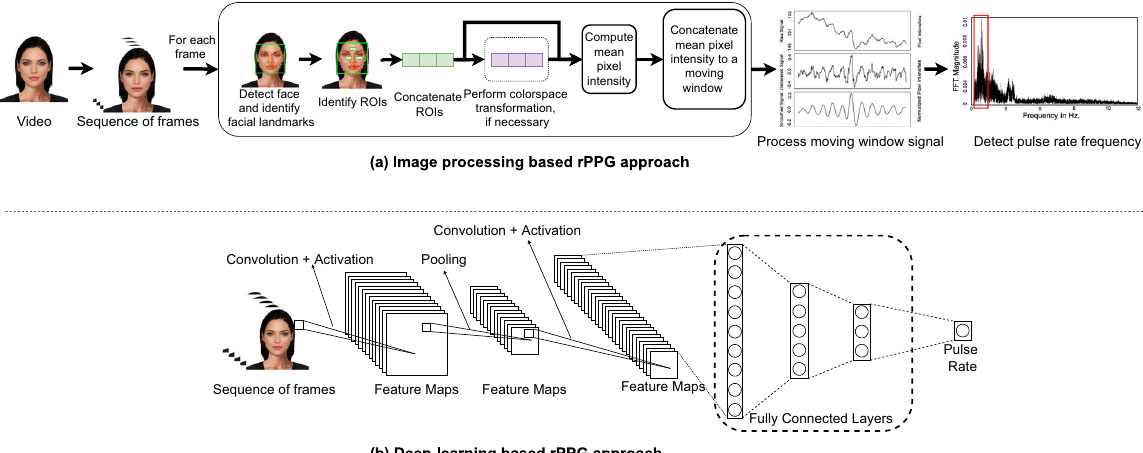
Fig. 6 rPPG approaches to estimating pulse rate. Figure a (top) shows image processing-based detection of heart rate from a facial video, detailing the steps of face detection, skin segmentation, color space transformation and signal processing. Figure b (bottom) shows a deep convolutional neural network that predicts the heart rate using a facial video as the